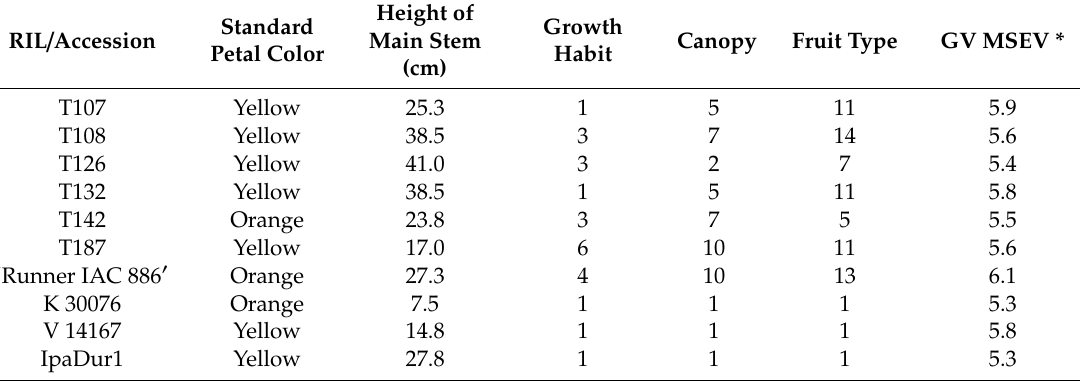
Table 4. Summary of agronomic traits and leaf spots resistance evaluation of selected